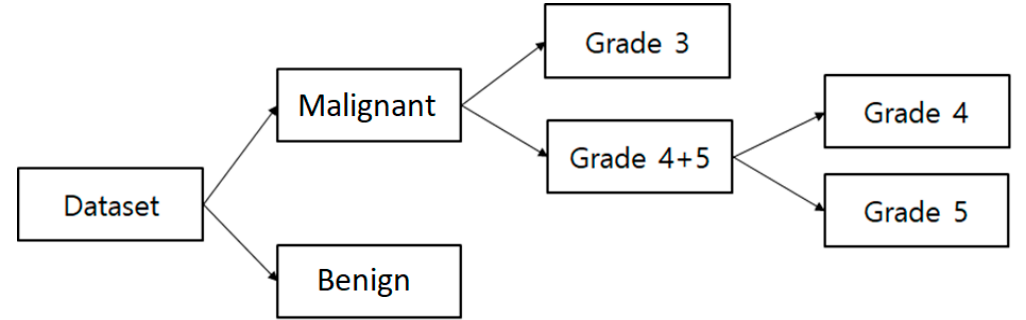
Figure 6. Proposed binary method for support vector machine (SVM) classification. Three different classifiers have been used here for binary classification and each group is classified independently and separately.